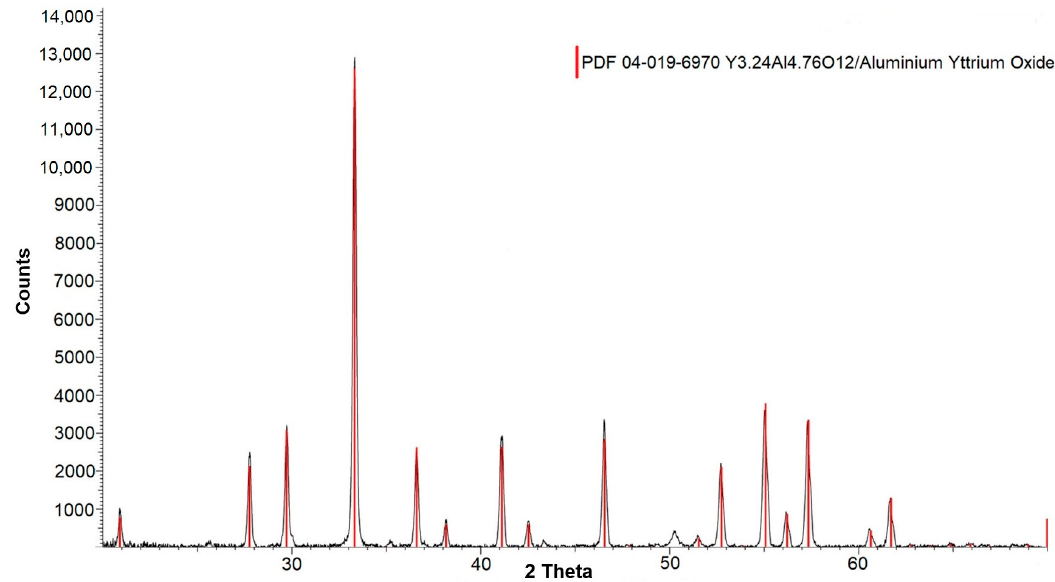
Figure 4. X-ray di ff raction spectra of YAG:Eu (10%). Figure 4. X-ray diffraction spectra of YAG:Eu (10%).